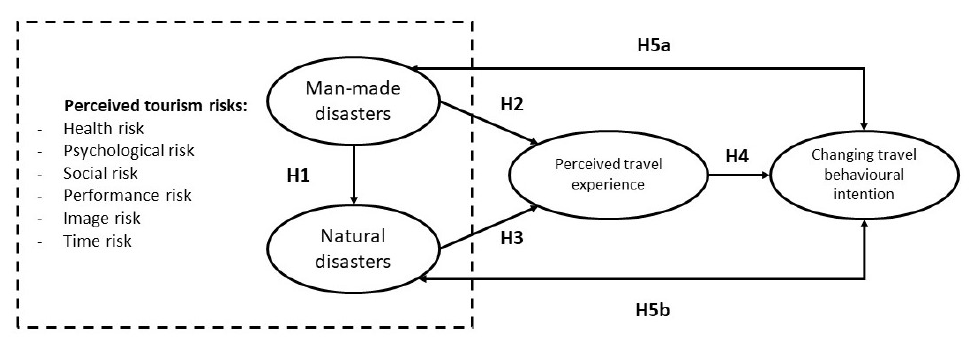
Figure 1. Conceptual model and hypotheses of the relationship between perceived tourism risks, perceived travel experience, and changing behavioural intention.